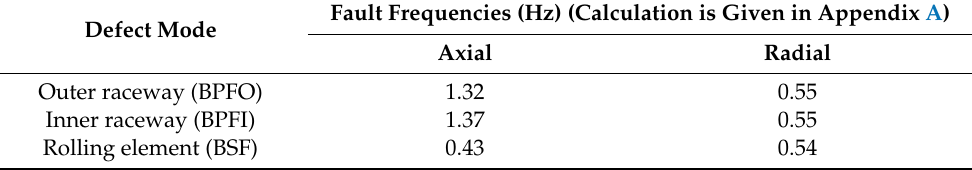
Table 2. Fault frequencies of slew bearing test-rig (run at 1 r/min).